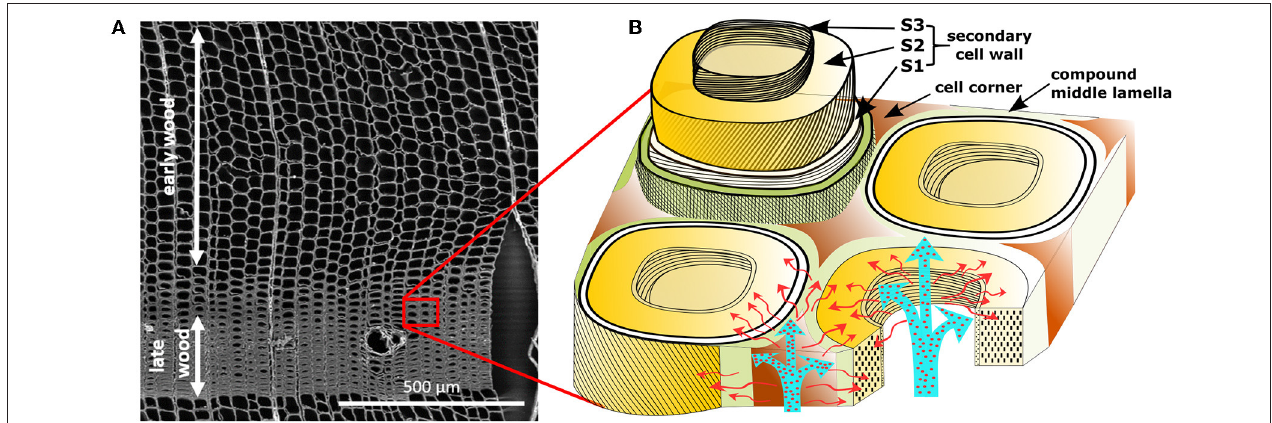
FIGURE 1 | Micro- and ultrastructure of wood. (A) SEM overview of honeycomb-like structure of spruce wood cells (tracheids) in the cross section. Early wood shows larger lumina, while late wood present higher cell wall/lumen volume ratios. (B) Cell wall model with potential diffusion pathways of aqueous media through the lumina and nano-porosity present in the cell wall. Cells are connected by a compound middle lamella (middle lamella + primary cell wall). The secondary cell wall consists of distinct layers, S1, S2, and S3, differentiated through chemical composition and cellulose microfibril